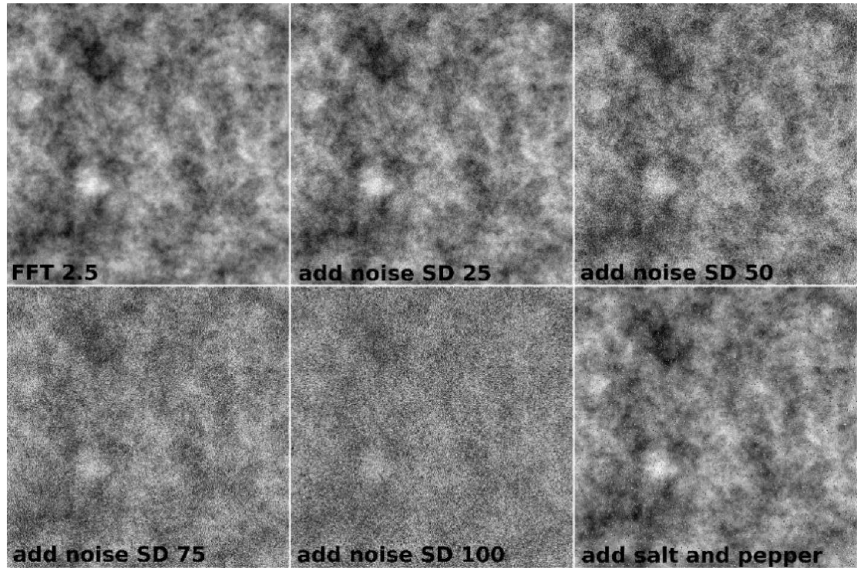
Figure 12. FS images of 8-bit grayscale with FD = 2.5. Added Gaussian noise with different SD and salt and pepper noise, at a resolution of 1000 × 1000 pixels.